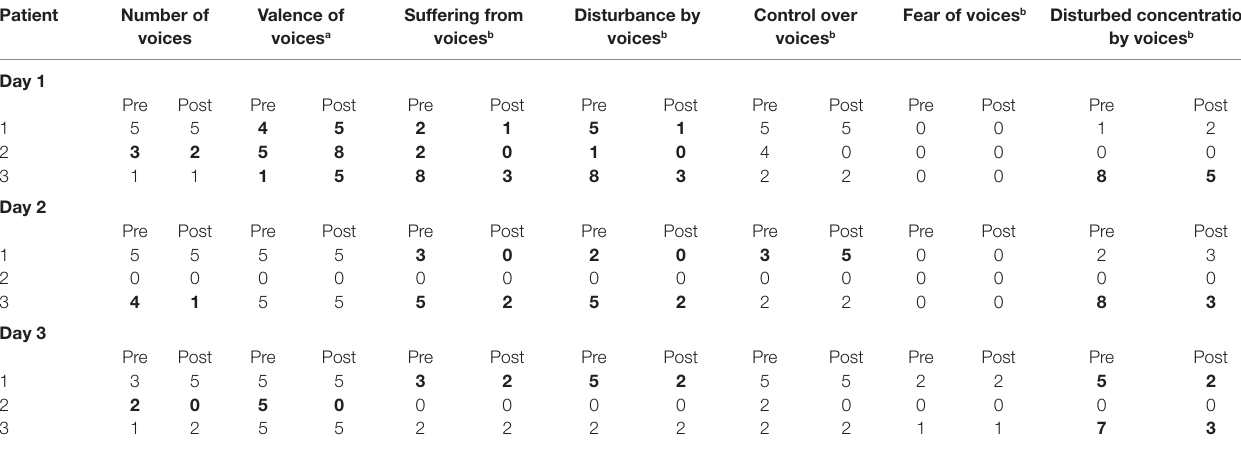
taBLe 2 | aVHRs before and after neurofeedback training on days 1, 2, and 3 (improvements in bold). patient Number of Valence of voices voices a